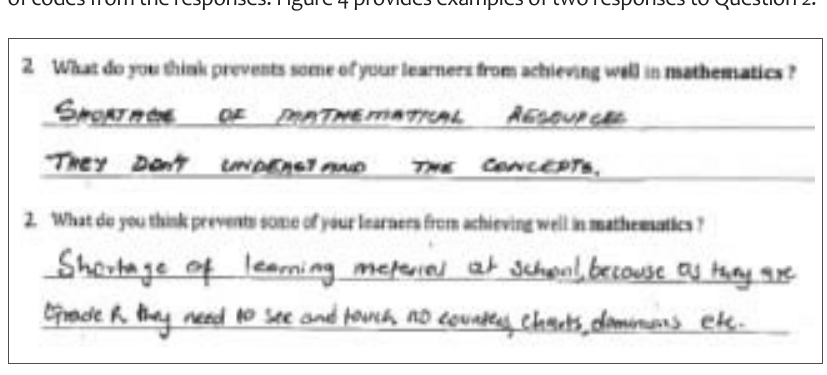
Figure 4: Extracts of two teachers’ responses to Question